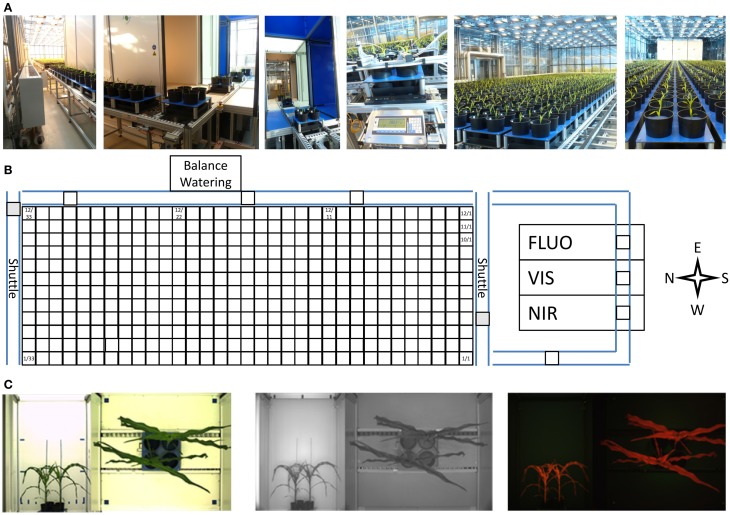
(A) Automated transport, imaging, and weighing/watering system for HT phenotyping of large plants (LemnaTec Scanalyzer). (B) The platform uses a conveyor system with two shuttles to automatically transport pot-grown plants in special carriers to three imaging stations for high resolution imaging and to a weighing and watering station. (C) Each carrier (carrying one or more plants) is imaged sequentially from the top and the side in multiple scanalyzer camera units for the visible light spectrum (left), near infrared (center) and fluorescence (right) imaging.